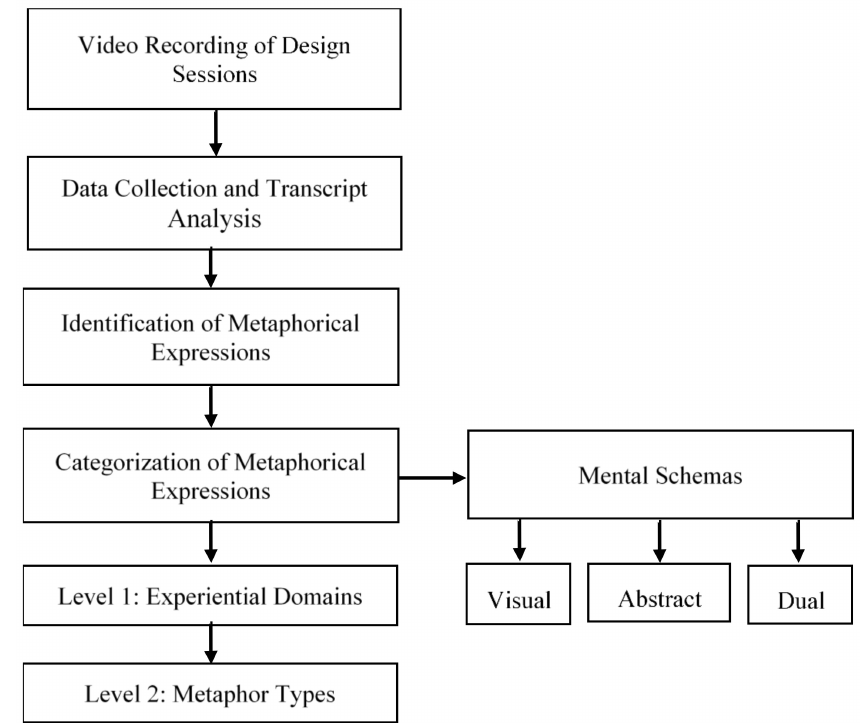
Figure 1. Description of the methodological path followed in the study of metaphors in architectural design. Extract